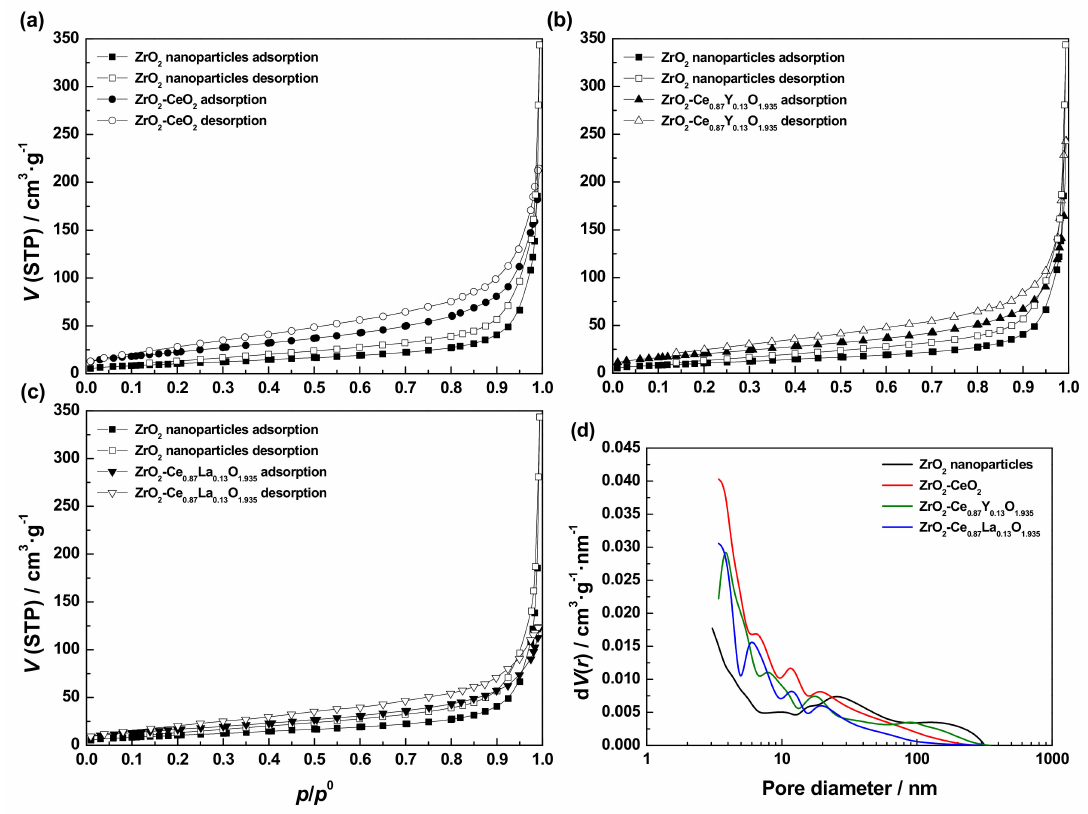
Figure 4. ( a – c ) Nitrogen adsorption-desorption isotherms at − 196 ◦ C and ( d ) BJH pore size distributions